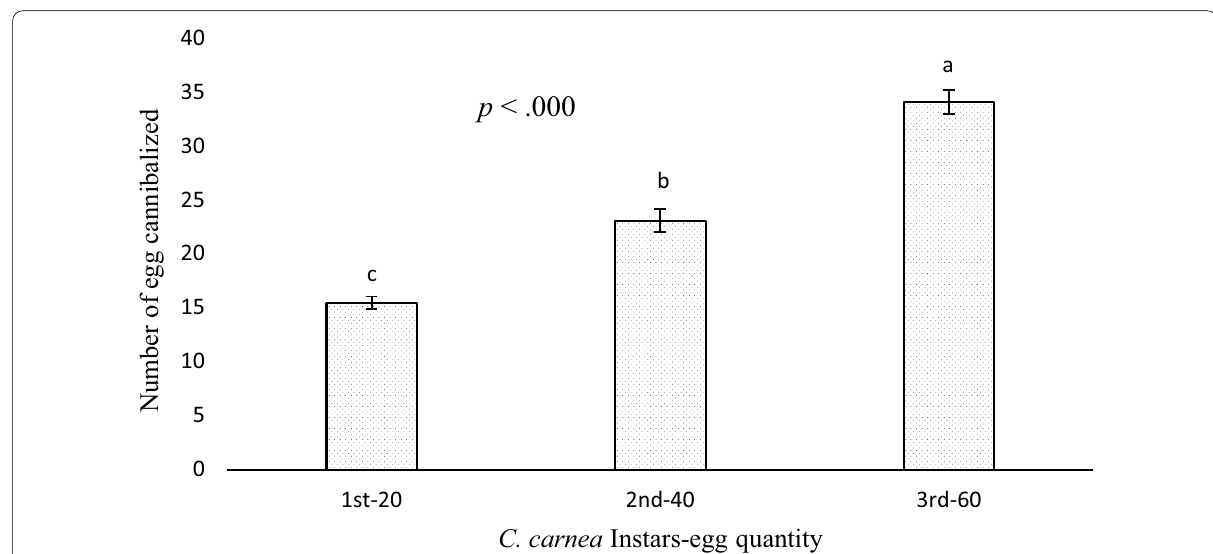
Fig. 2 Conspecific egg cannibalism by larval instars of C. carnea . Each bar represents mean egg consumption ( Difference in letters above the bars indicates significant ( p <